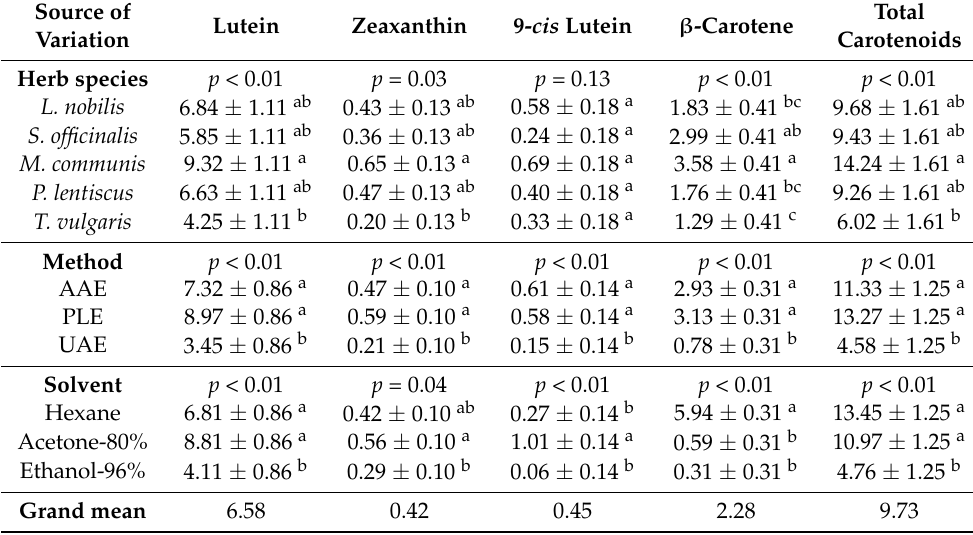
Table 1. Carotenoid content, as determined via the HPLC-DAD method (mg 100 g − 1 DW), in the extracts of selected Mediterranean herbs, obtained through sequential solvent extraction by different extraction